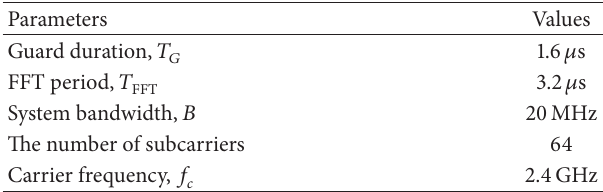
Table 1: The simulation parameter set-up of the OFDM